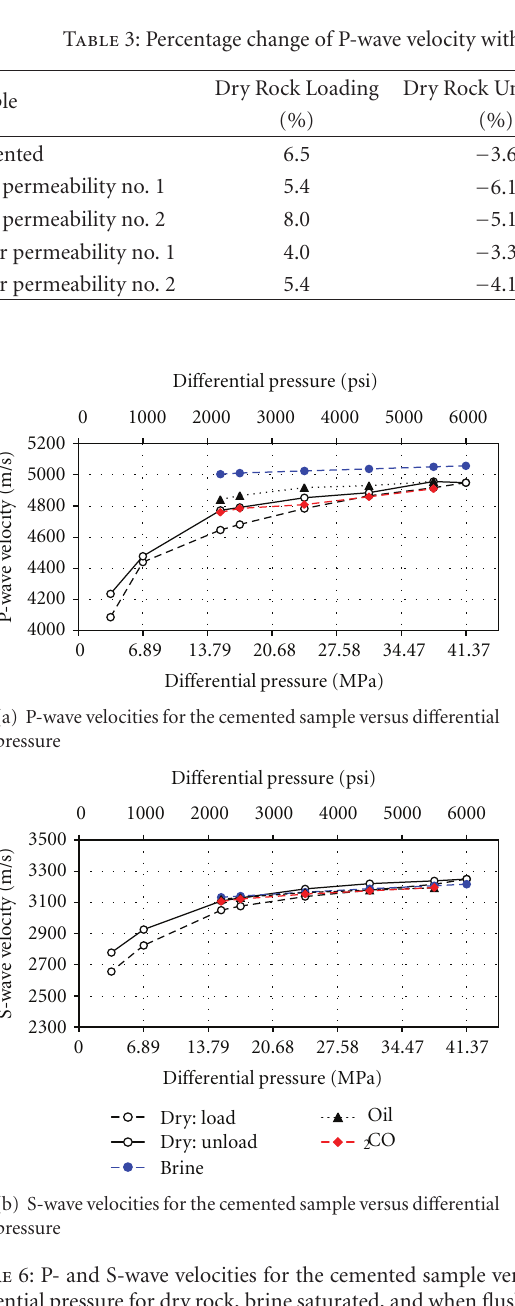
Figure 6: P- and S-wave velocities for the cemented sample versus di ff erential pressure for dry rock, brine saturated, and when flushed with live oil and CO 2 .